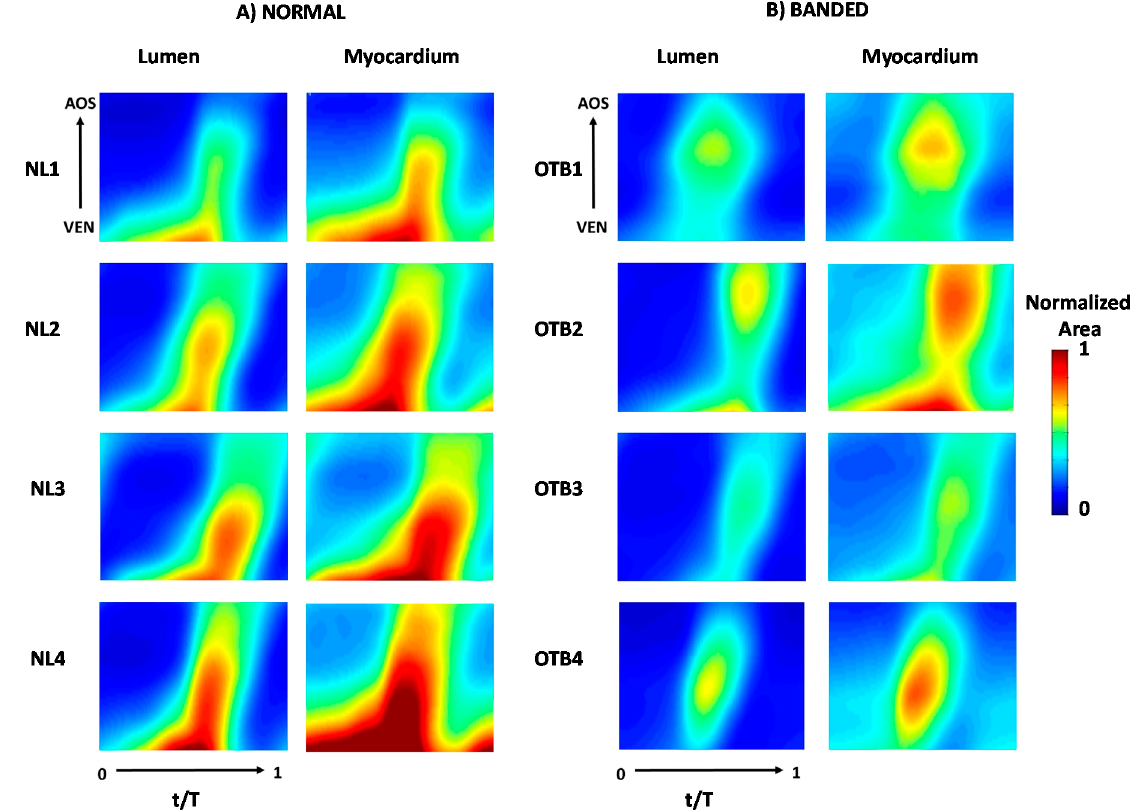
Figure 5. 2D area plots of the OFT lumen and myocardium. The plots compare the motion of ( A ) four normal (NL); and ( B ) four banded (OTB) embryos. In each plot, the x-direction (horizontal direction) indicates normalized time over the cardiac cycle, with t time and T cardiac cycle period; the y-direction (vertical direction) indicates normalized length along the segmented portion of the OFT from the section closer to the ventricle (VEN) to the section closer to the aortic sac (AOS), which determines the end of the OFT. Areas are normalized to the maximum lumen area of the normal embryos (occurring for NL4), and, thus, the maroon color features saturation (area > 1) for some myocardium plots. The data shows biological variations among embryos as well as the effects of banding on OFT wall motion. It is evident that the band does not merely constrict the lumen area, but its placement affect cardiac wall motion and mechanics.